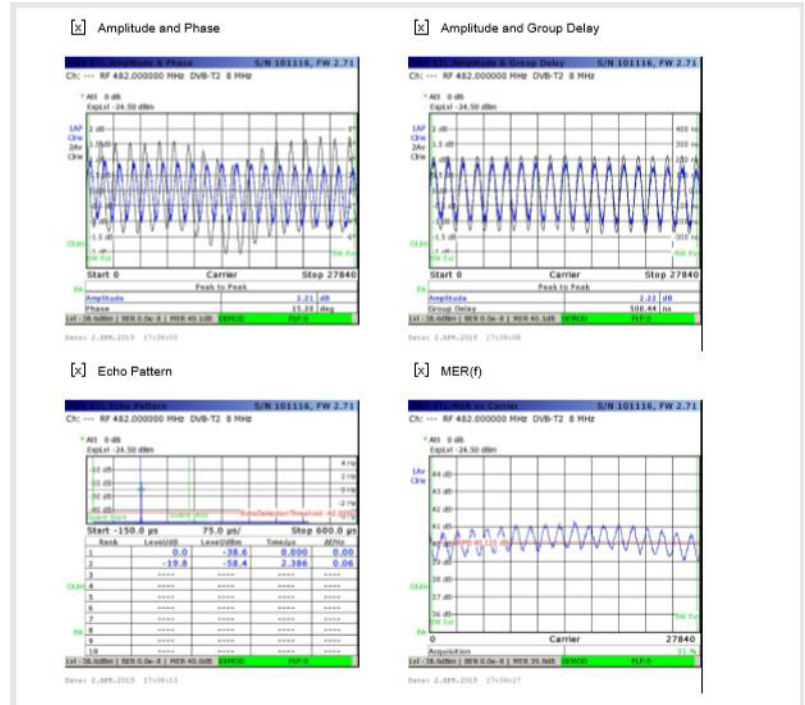
Figure 15. DVB-T2 Signal Form and Values parameters measured in the SFN mode: Level, -38.6 dBm; Δ Level, -19.8 dB; Amplitude 2,15 dB; Phase 15.6 deg; MER(f); MER (PLP, rms) 40.1 dB; Time offset 2